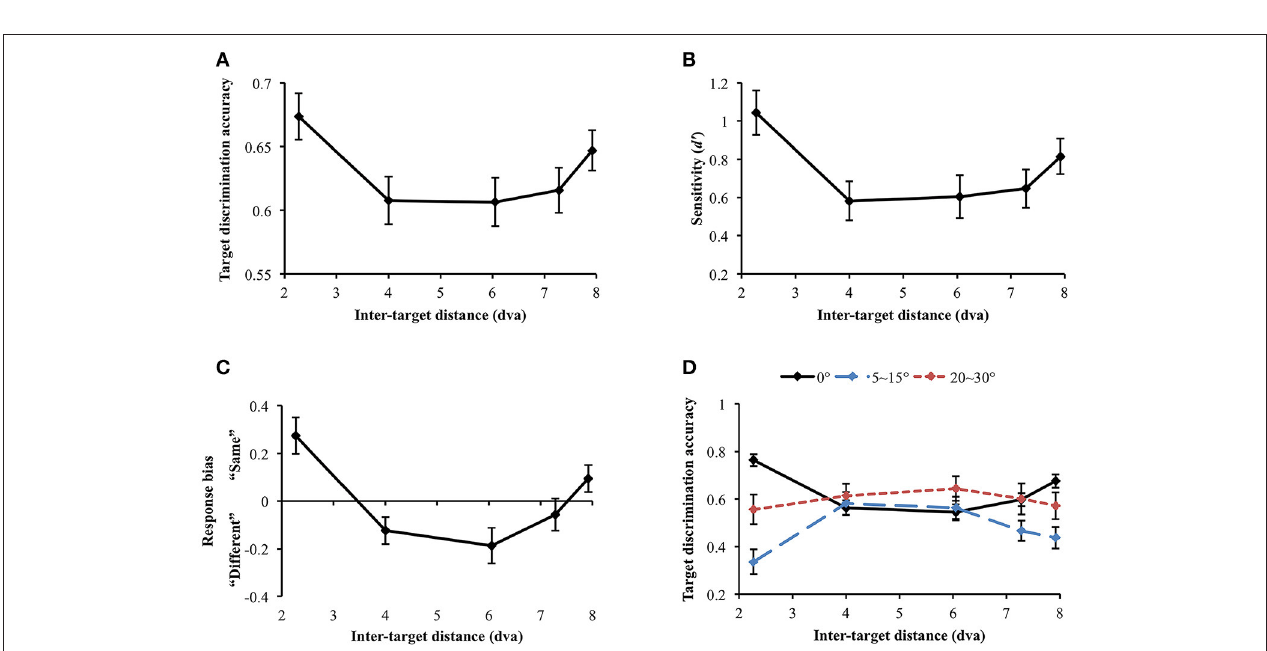
FIGURE 4 | (A) Target discrimination accuracy (proportion correct) of Experiment 1. Accuracy was highest when the two targets were spatially closest (separated by 2.27 dva) and sharply decreased at the second closest distance (4 dva). It eventually recovered at the farthest distance (7.92 dva), demonstrating a U-shaped profile. (B) Participants’ sensitivity for same-different discrimination ( d ′ ) also exhibited the comparable U-shaped profile. (C) Response bias changed along d ′ , demonstrating that “same” judgment, which requires thorough visual scrutiny, is associated with higher sensitivity. When attentional surround suppression plays, sensory evidence lacks so it would be more difficult to respond “same.” (D) Target discrimination accuracy varied depending on both orientation difference between the target stimuli and inter-target distance. When the target stimuli had the same orientation, accuracy was greatest at the closest inter-target distance, leading the U-shape profile. A typical attentional surround suppression profile (lowest accuracy at the closest inter-target distance) was observed when orientation difference between the targets was 5–15 ◦ . Surround suppression was not apparent when orientation difference became greater (20–30 ◦ ). Error bars indicate SEM.